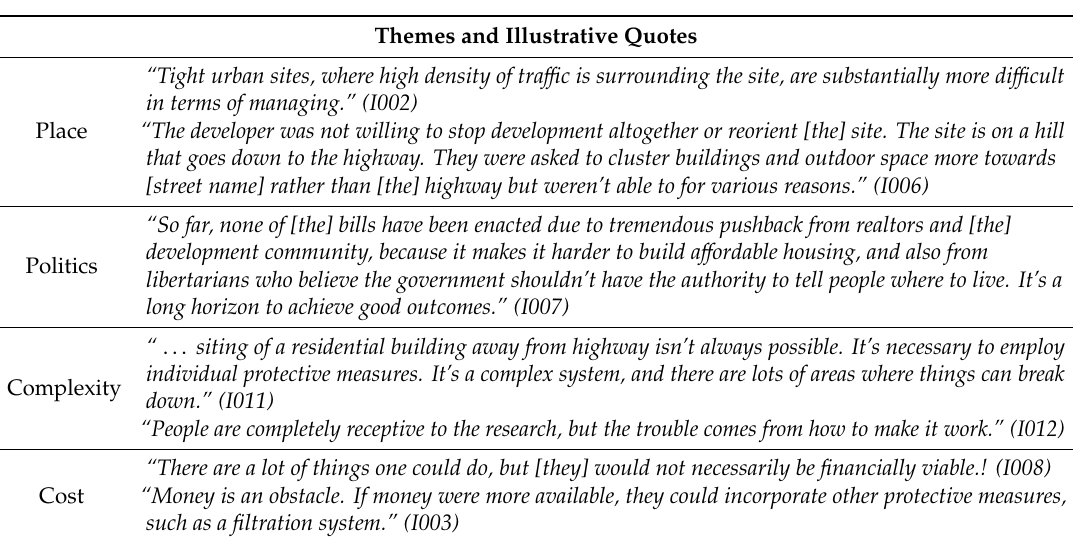
Table 2. Barriers to mitigating near-roadway